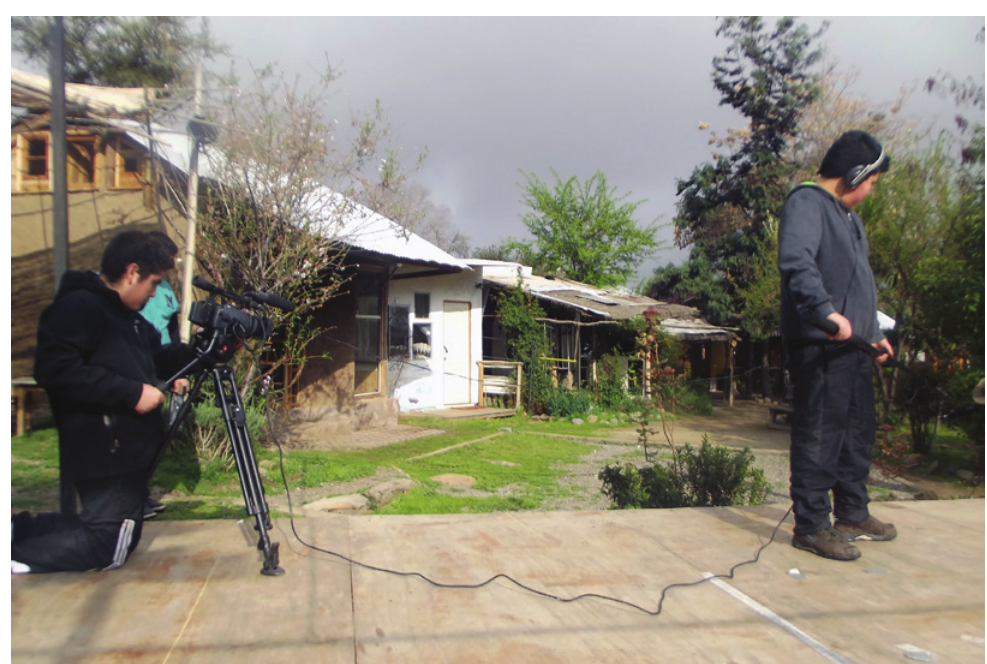
Figure 7: Exploratory shots in Patio La Rosa: Gardening Source: Colegio